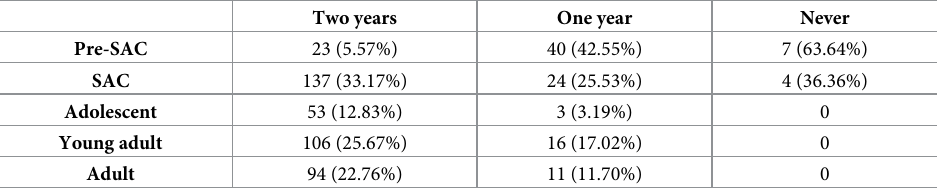
Table 3. Percentages of individuals in all four kebeles stratified by age group and sample sizes stratified by age group, who fall into the three treatment compliance groups (never treated, treated once, and treated twice so fully